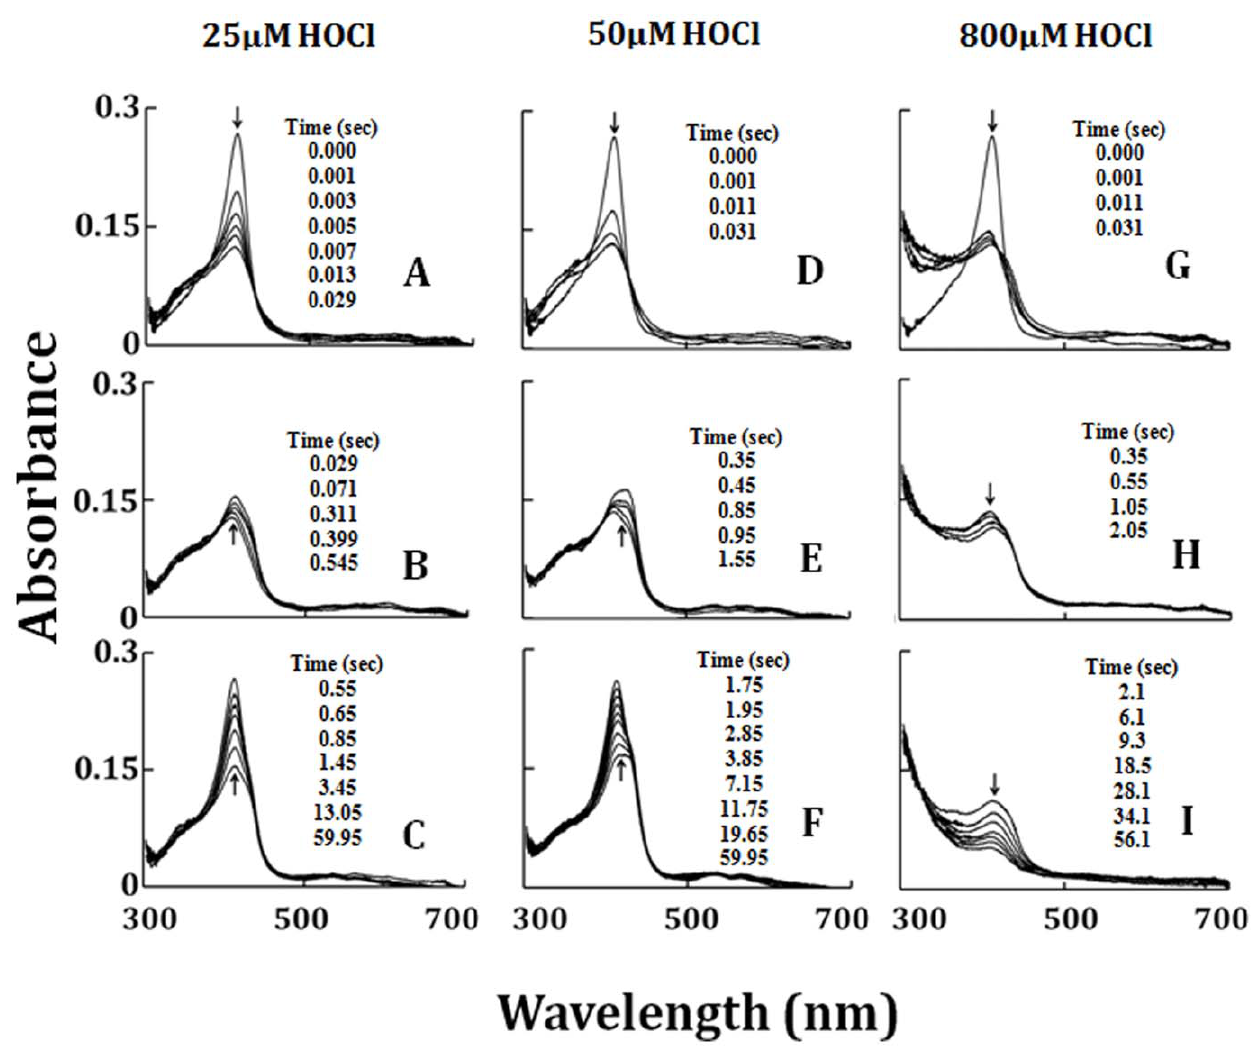
Figure 2. Formation of LPO Compound I and II and their exhaustion through the reactions of LPO-Fe(II) with increasing concentration of HOCl. Rapid-scanning diode array spectra were recorded during the reaction of LPO-Fe(III) (3 m M) with a buffer solution containing 25 m M (Panels A, B, and C), 50 m M (Panels D, E, and F), and 800 m M (Panels and G, H, and I) HOCl, at 10 u C. Selected spectra were omitted from each panel for clarity. Arrows in the panels indicate the direction of spectral change over time. The time of each collected spectrum after initiation of the reaction is indicated in seconds. The data are representative of three independent experiments. doi:10.1371/journal.pone.0027641.g002 (Fig. 2E), which then decays immediately to LPO-Fe(III) (Fig. 2F).